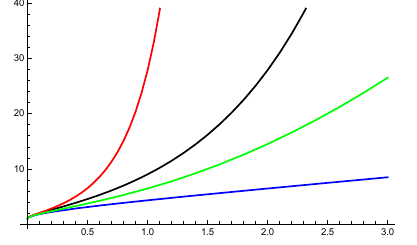
Figure 1. Solutions to (4.8) with a = 0, ω = 1, f ≡ 1, α = 1 , x a = 1 and 1. λ = 0, 2 Ψ ( t ) = t (black); 2. λ = 1, Ψ ( t ) = t (blue); 3. λ = 0, Ψ ( t ) = t + t 2 (red); 4. λ = 1, Ψ ( t ) = t + t 2